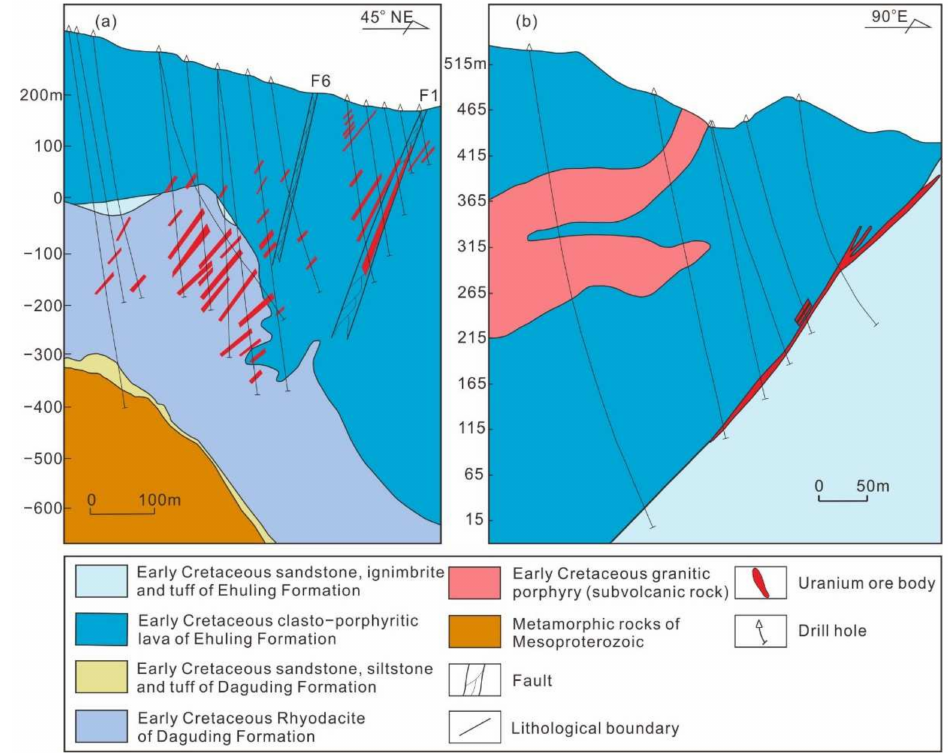
Figure 2. Typical geologic profiles for uranium prospecting at Zoujiashan deposit ( a ) and Yunji deposit ( b ) (modified from Zoujiashan and Yunji exploration